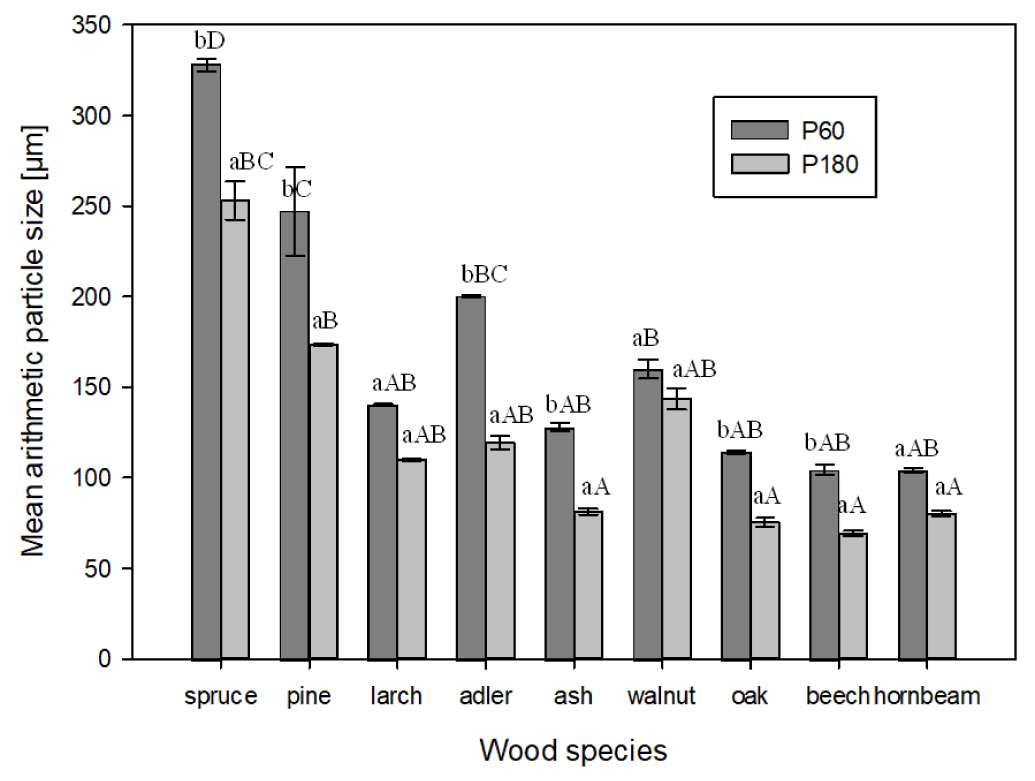
Figure 3. Analysis of the mean arithmetic particle sizes of dust; a, b: the same letters indicate no significant di ff erences at the significance level of 0.05 between sandpaper grit size; A, B: the same letters indicate no significant di ff erences at a significance level of 0.05 between wood